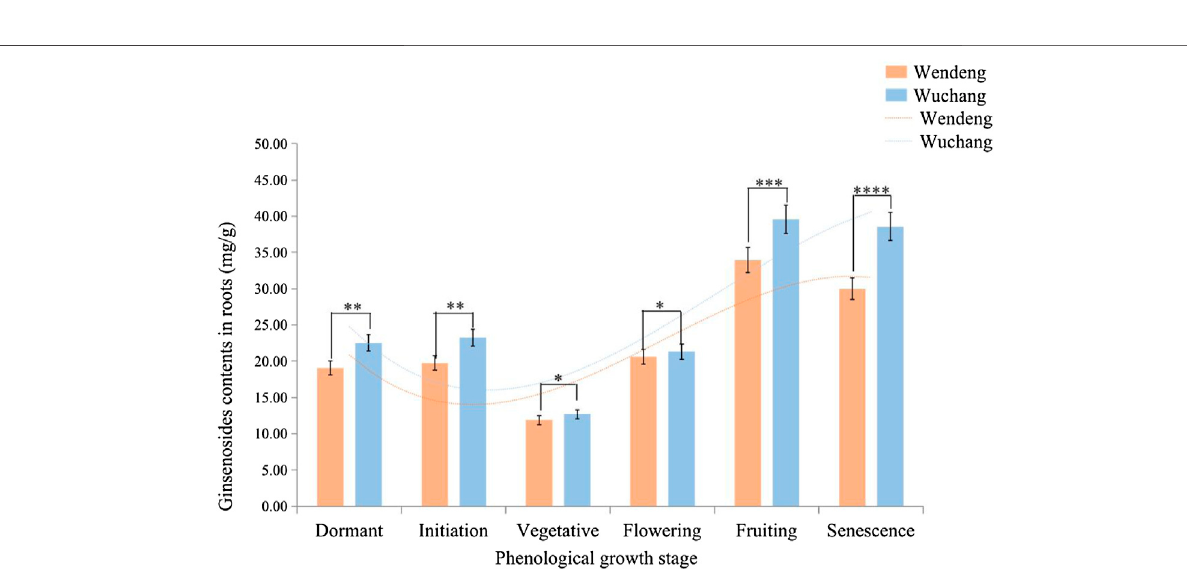
Frontiers in Earth Science |